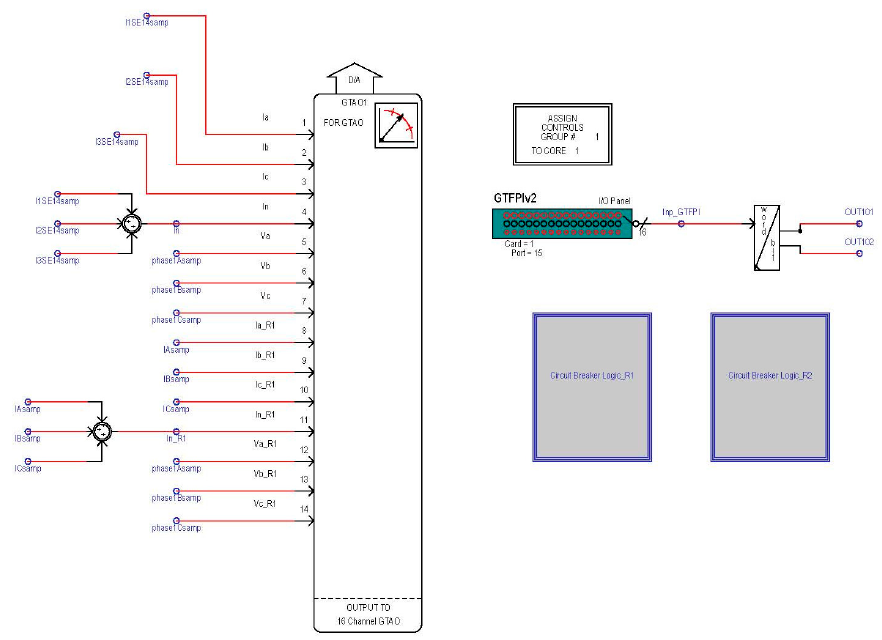
Figure 3. Module 2 of the RSCAD model.